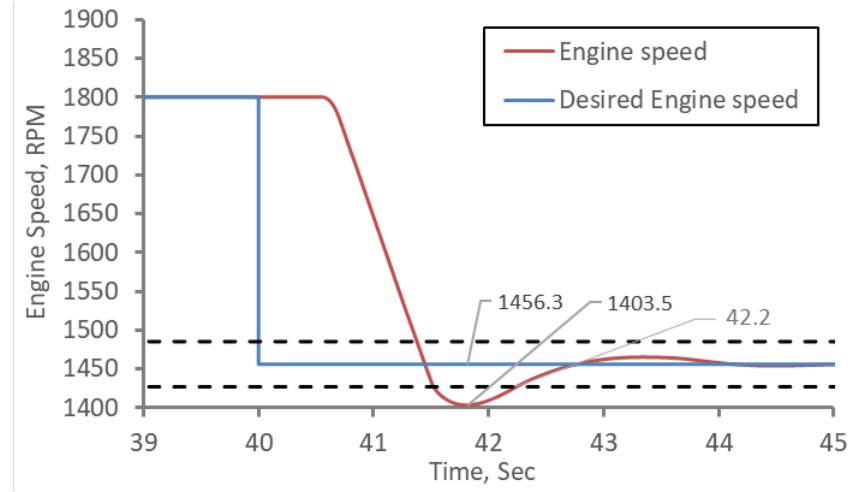
Figure 10. Maximum overshoot and settling time of engine speed controller from step input.